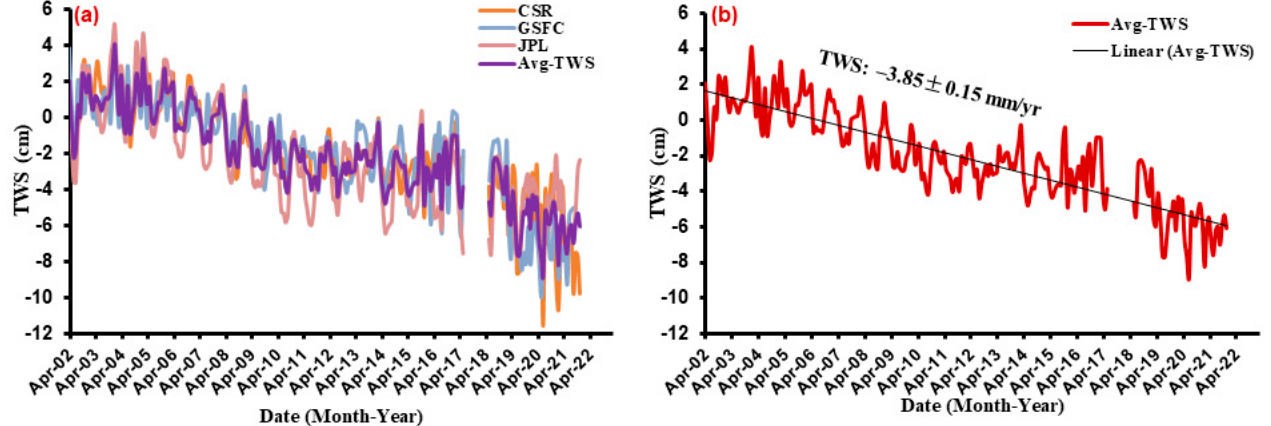
Figure 7. Correlation coefficient (R) between ∆ TWS data from the averaging of JPL and CSR mascon solutions ( a ); GSFC and CSR mascon solutions ( b ); and JPL and GSFC mascon solutions ( c ) over the wadi region.